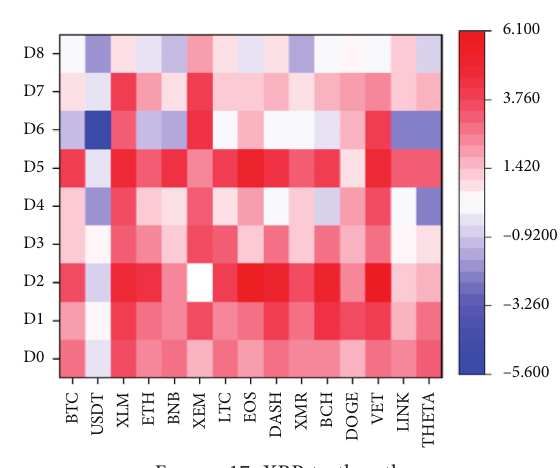
Figure 17: XRP to the other.